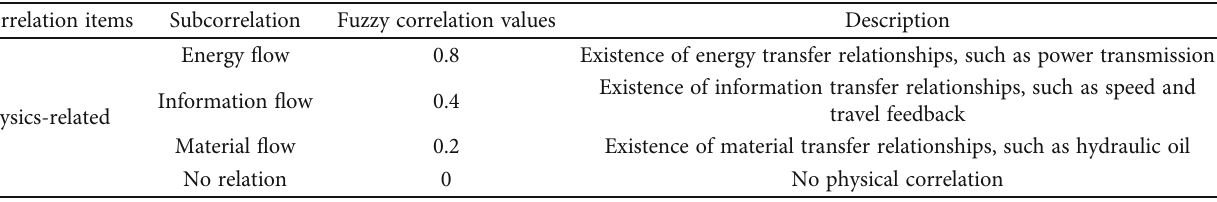
Figure 2: Individualized product module division method. Table 1: Physical correlation.